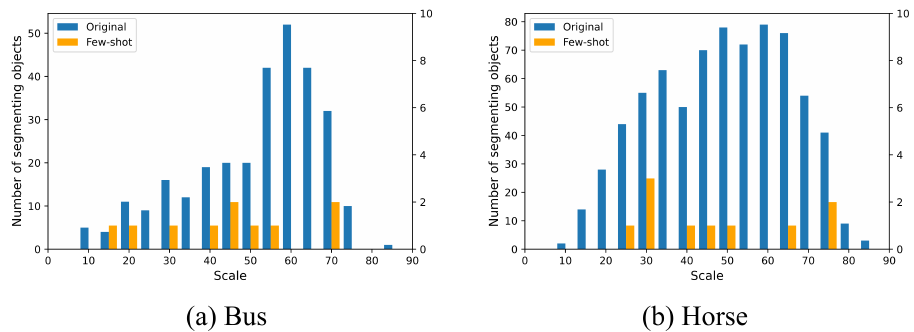
Figure 1. Proportional distribution maps of image targets for two specific classes: ( a ) bus and ( b ) horse, in PASCAL-5 i (Original) and a 10-shot subset (Few-shot). The object scale is calculated by (cid:113) + w 2 S obj = h 2 , where h obj and w obj are the height and width of the object. From the figure, we obj obj can find that the target scale distribution in few-shot learning will deviate from the original datasets.